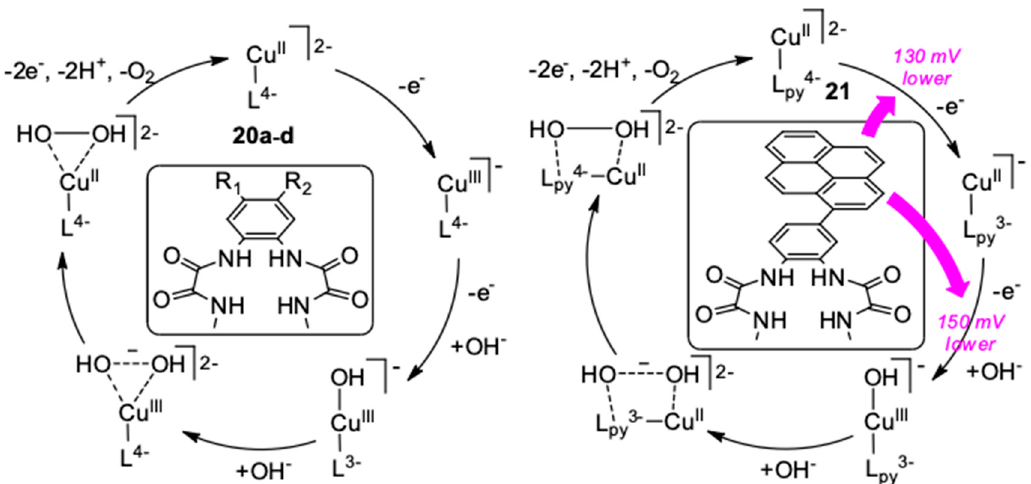
Figure 12. Mechanism proposals for WOCs involving redox non-innocent ligands and the effect of extended π -delocalization [30,61].